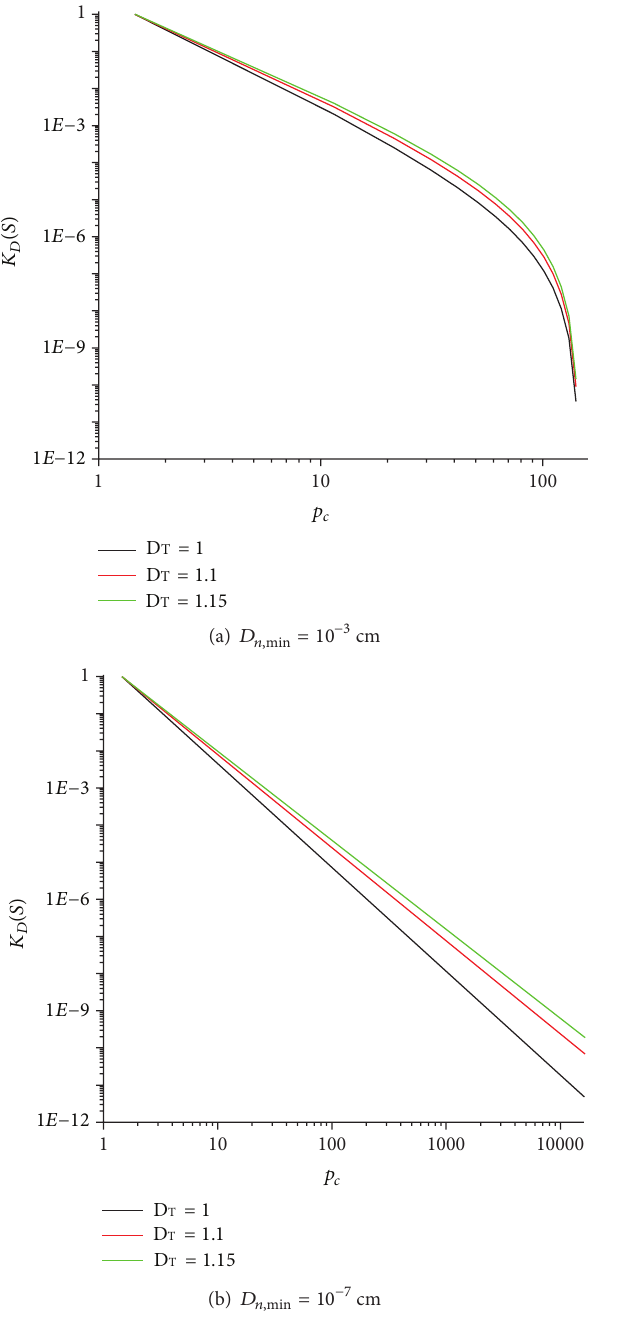
Figure 3: The new relations for 𝐾 𝐷 (𝑆) and 𝐷 𝑇 .